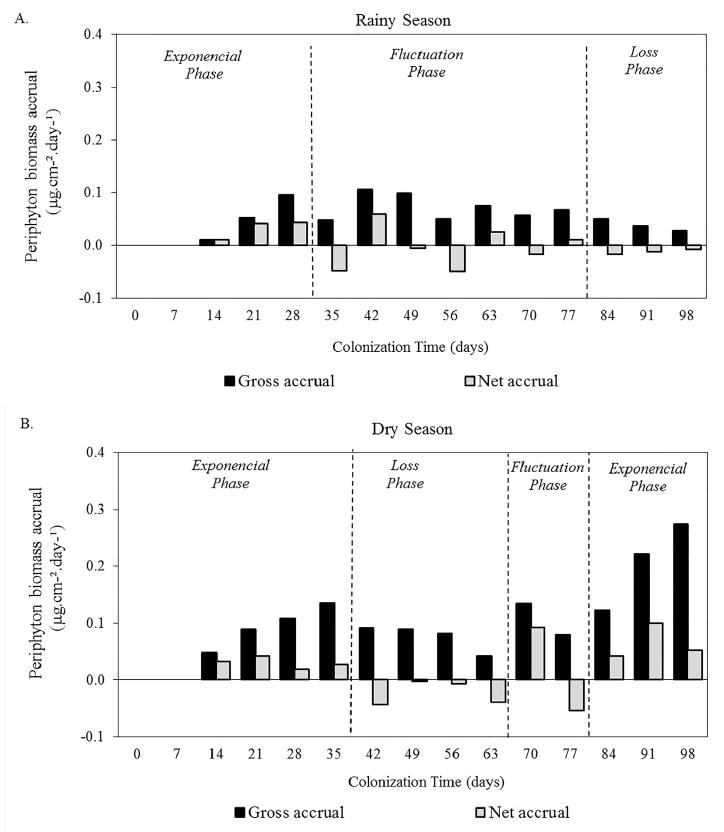
Figure 5. Periphyton gross and net accrual rate (chlorophyll a ) over the colonization process in the rainy (A) and dry (B) seasons in a shallow mesotrophic